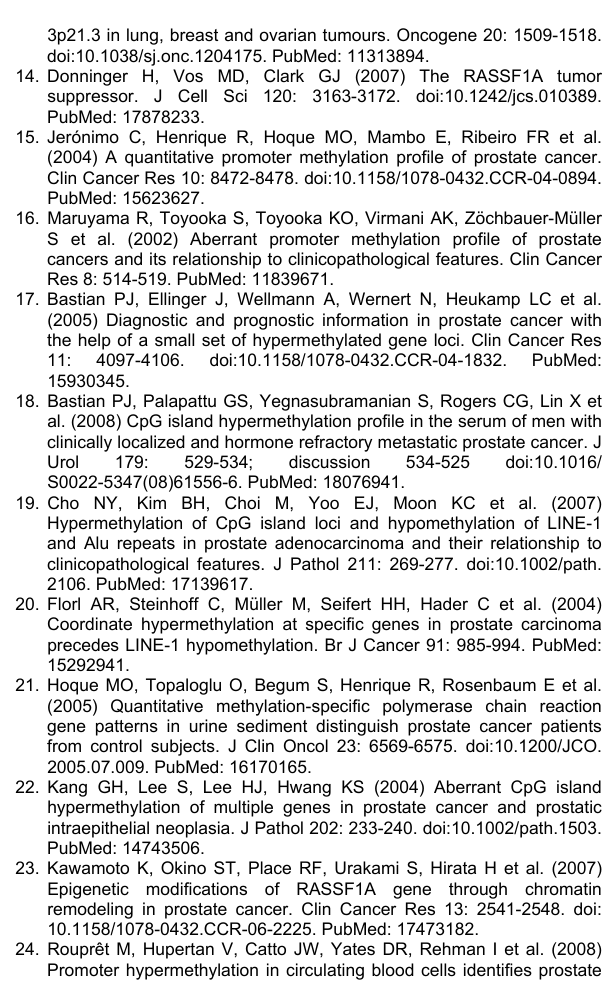
Table S1. Characteristics of studies included in the meta- analysis.